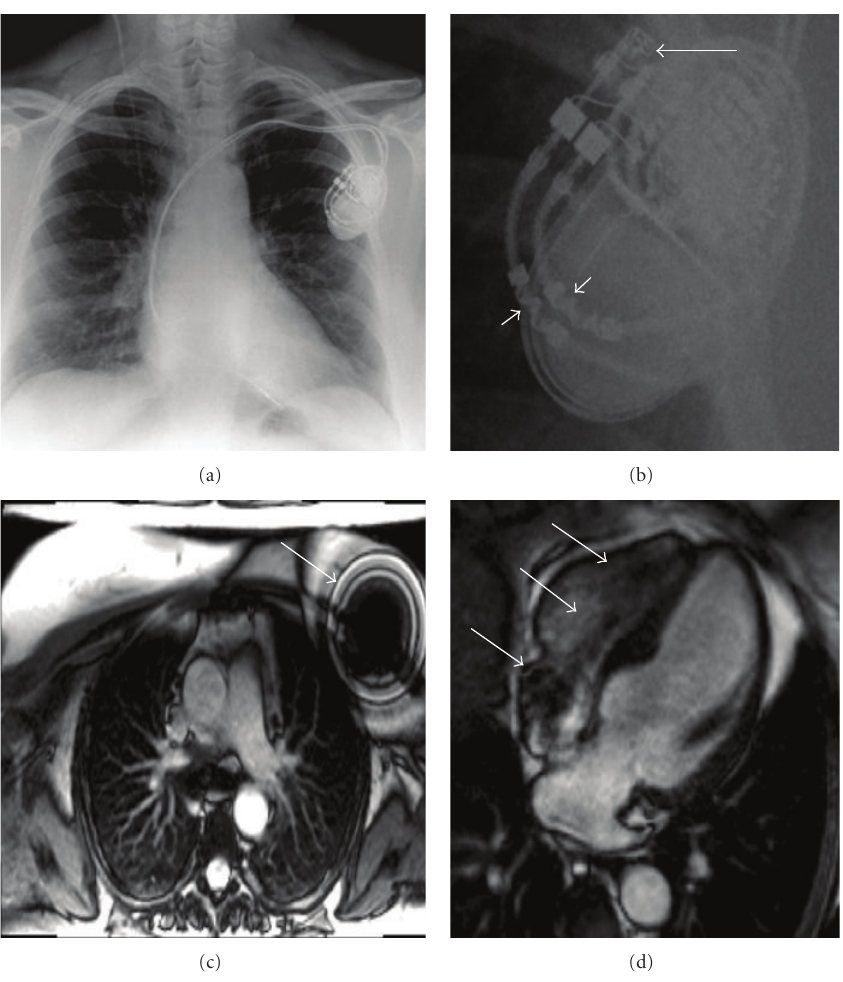
Figure 1: A CMR conditional pacemaker. (a, b) show the pacemaker on a chest X-ray. On (b) the arrows point to MRI conditional markers on the header and leads. (c) shows a large artifact from the pacemaker box on a transverse white blood stack. (d) shows suseptibility artifact from the pacemaker leads in the heart.